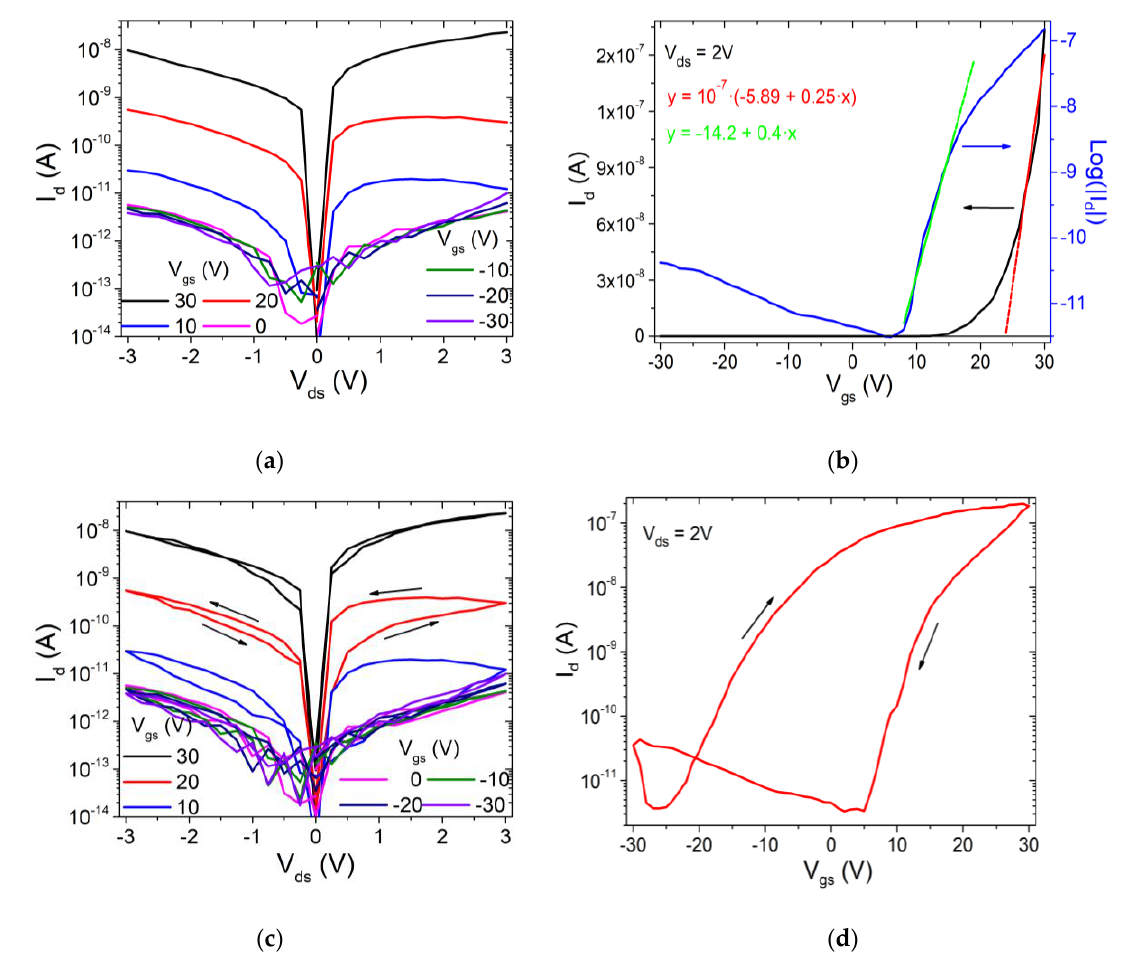
Figure 2. Electrical measurements at normal atmospheric pressure: ( a ) Output curves for reverse V ds sweep (single). ( b ) Transfer curve on linear (black) and logarithmic (blue) scale. ( c ) Output curves for forward and reverse V ds sweeps. ( d ) Transfer curves for forward and reverse V gs sweeps, showing a wide hysteresis.